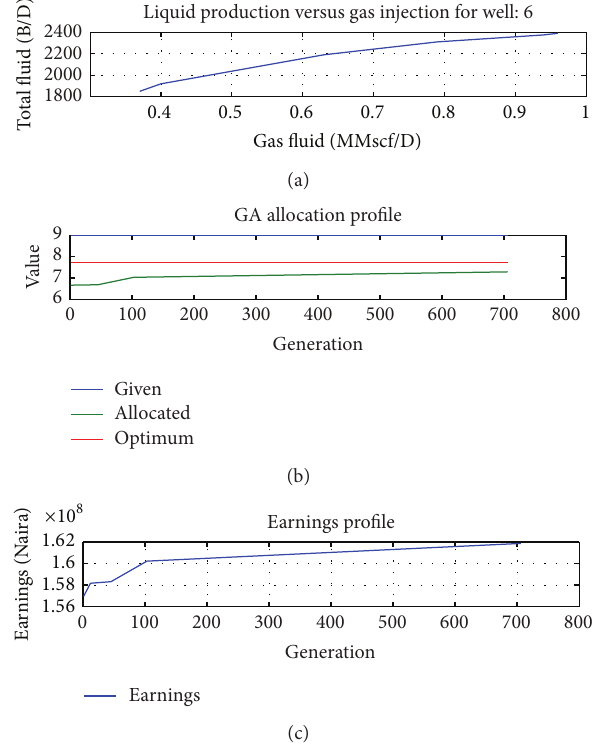
Figure 13: Well 6’s allocation profile, wells 1–6 GA allocation profile, and earnings (Naira) for an unlimited